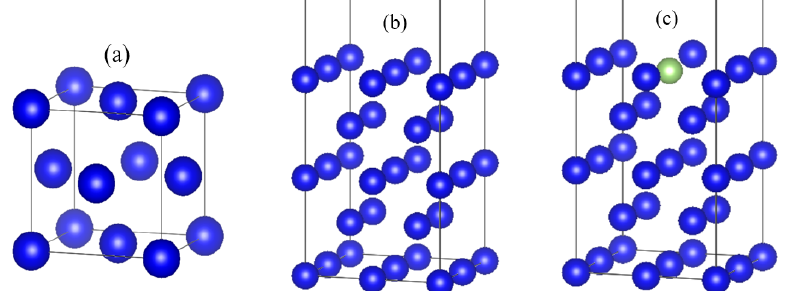
Figure 1. ( a ) Single cell structure. ( b ) Surface model. ( c ) Plutonium gallium system model (The blue spheres represent plutonium atoms, and the green spheres represent gallium atoms).